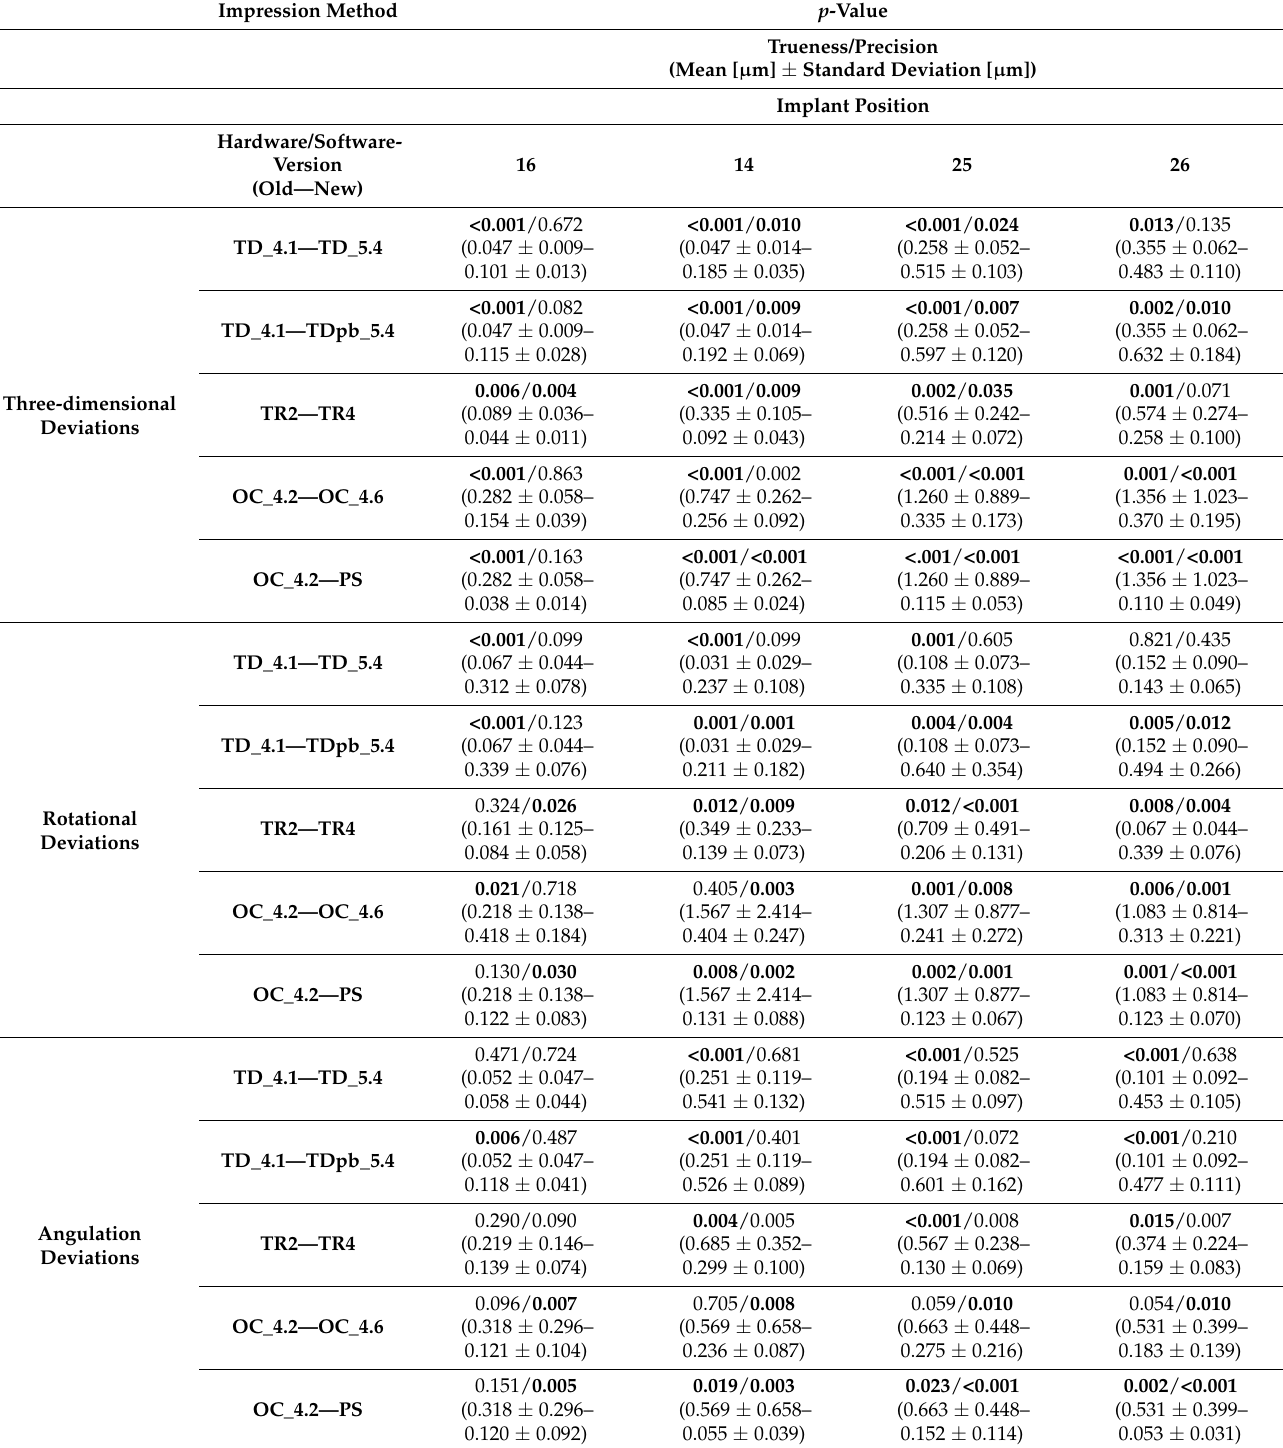
Table 2. Statistical analysis of the implant positions (FDI: 16, 14, 24, 26) and impression methods (TD_4.1: True Definition scanner (Cart version) 4.1; TD_5.4: True Definition scanner (Cart version) 5.4; TDpb_5.4: True Definition scanner